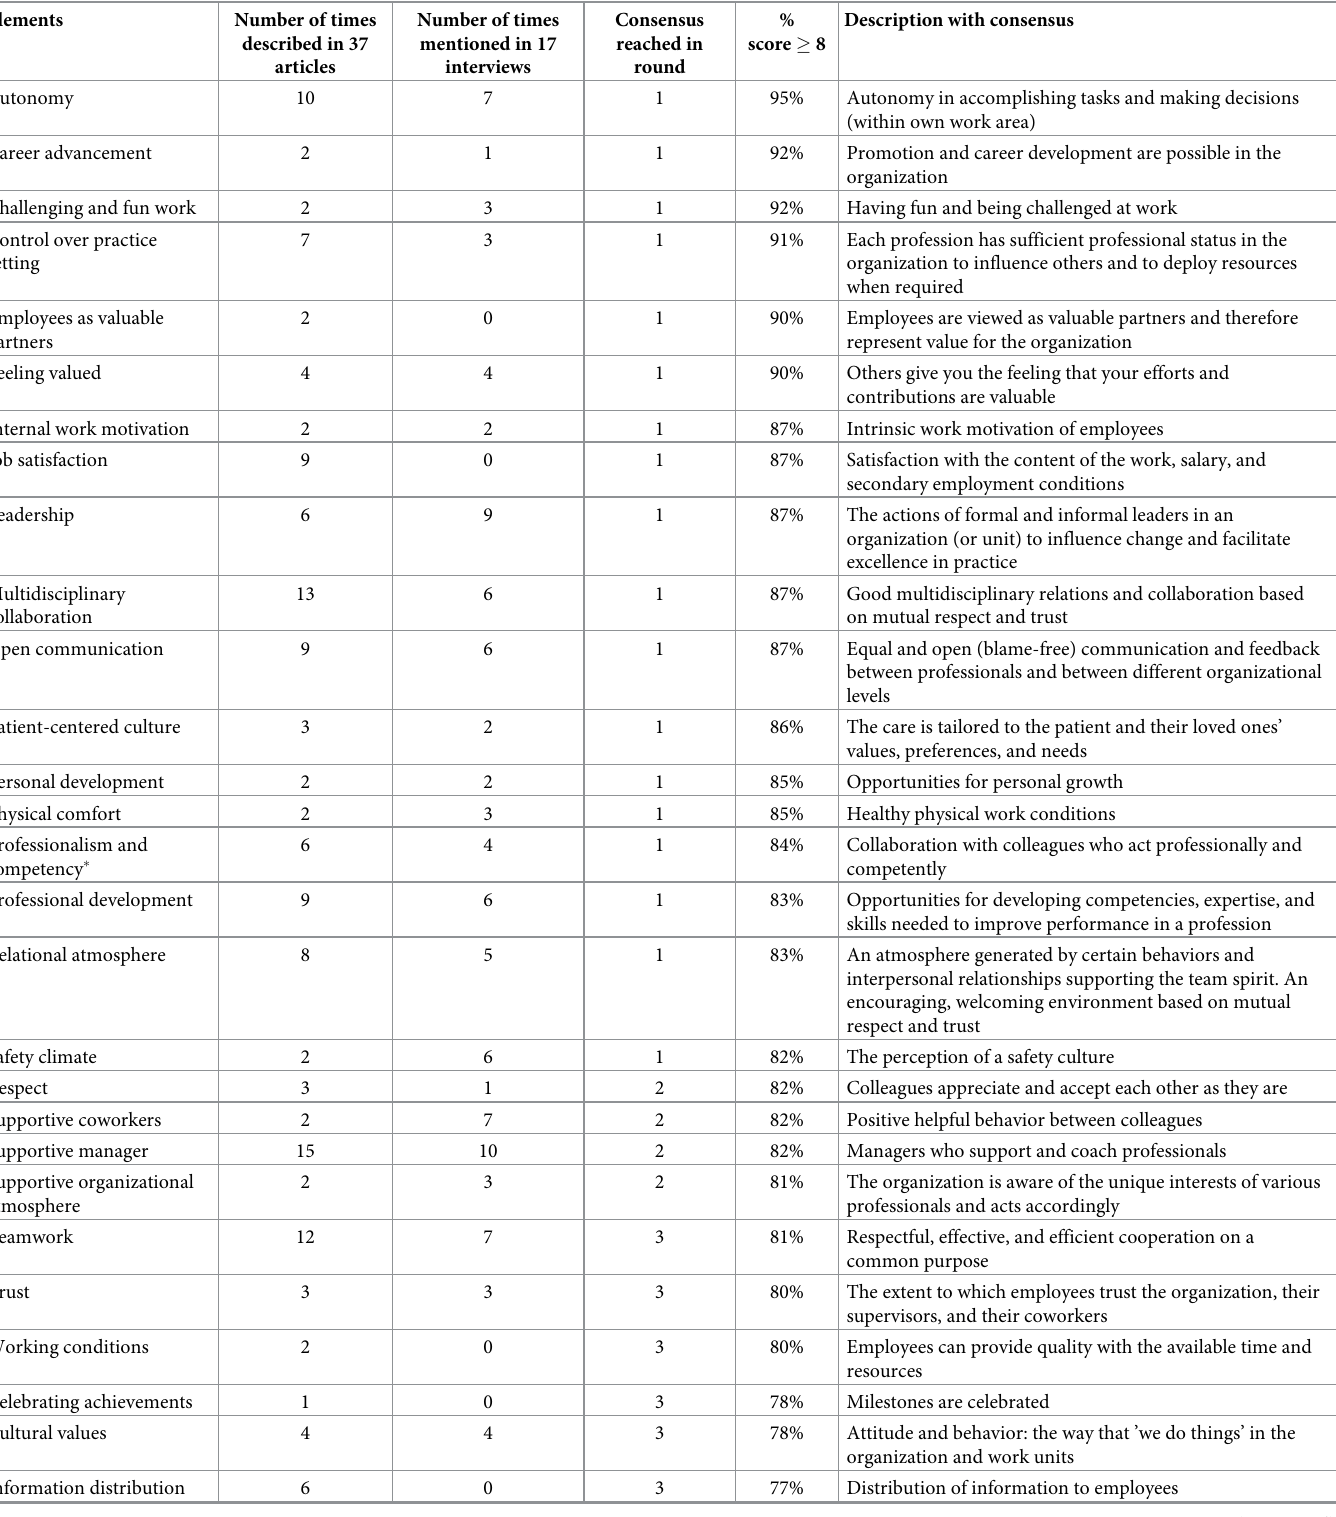
Table 3. Overview of results from the Delphi